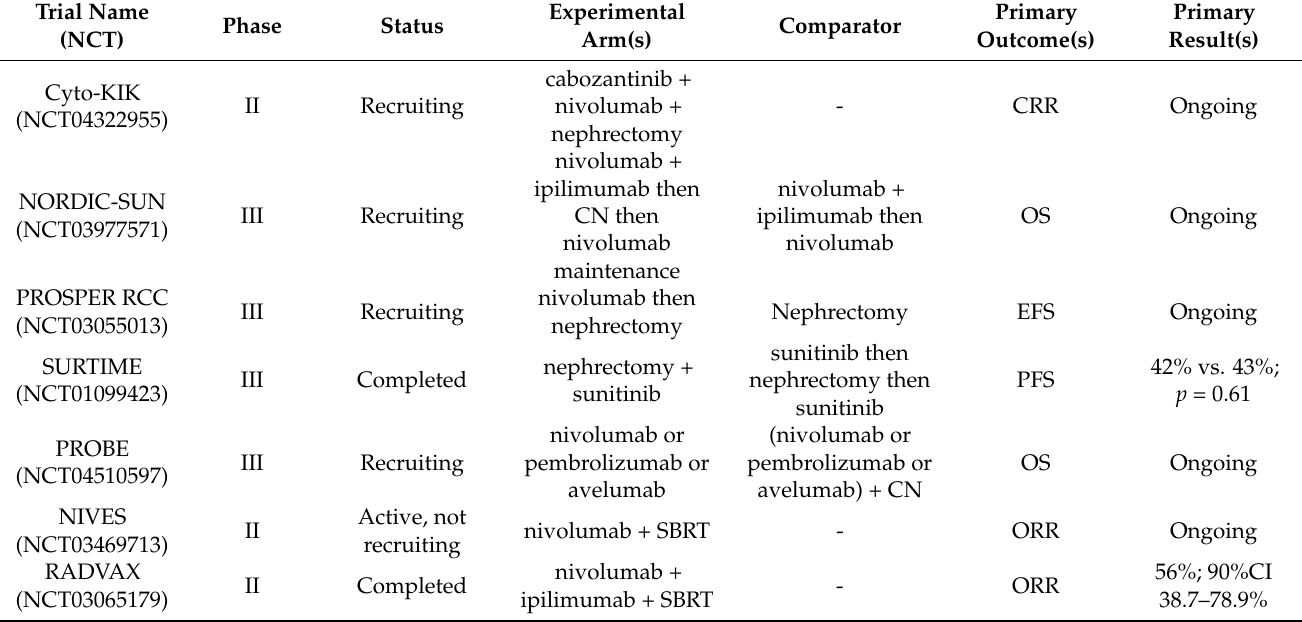
Table 4. Clinical trials investigating the role of ICI + CN or ICI + SR. OS—overall survival. CRR—complete response rate. PFS—progression free survival. EFS—event-free survival. ORR—objective response rate. HR—hazard ratio. SBRT— stereotactic body radiation